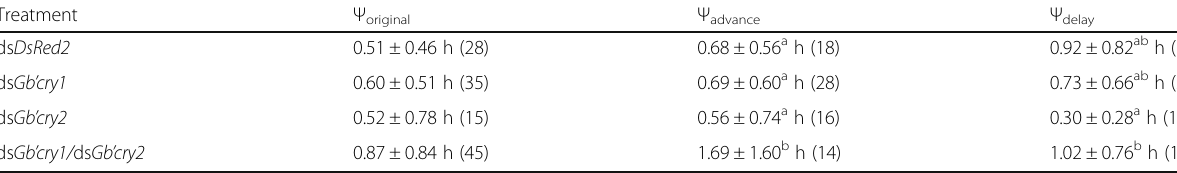
Table 1 Effects of Gb ’ cry1 and Gb ’ cry2 RNAi on the phase relationship between light-off and activity onset. Different lower case letters indicate that values are significantly different (ANOVA followed by Tukey-test, P < 0.05). Ψ advance and Ψ delay indicate reestablished phase relationship after 6 h phase advance or delay of LD cycles, respectively. Numbers in parenthesis indicate number of animals used Treatment Ψ original Ψ advance Ψ delay ds